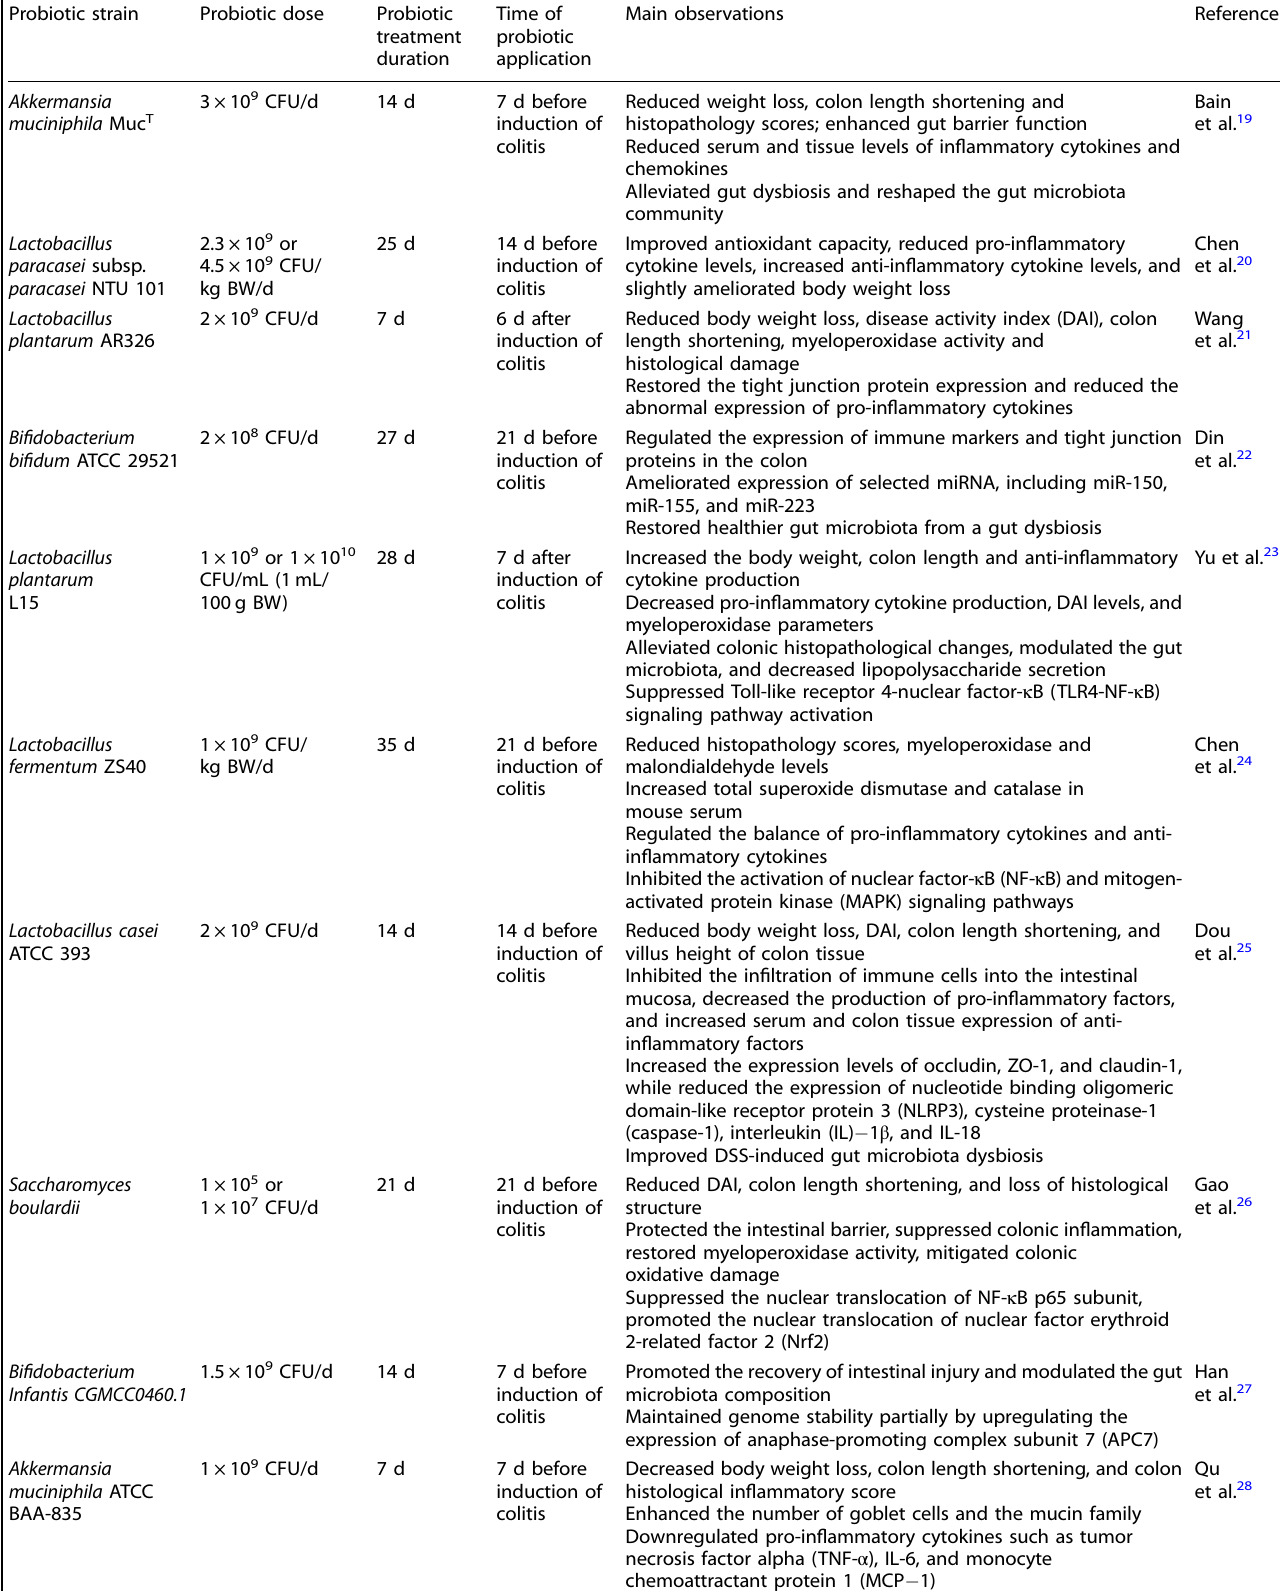
Table 1. Summary of major rodent studies investigating the protective effect of probiotics against dextran sulfate sodium (DSS)-induced ulcerative